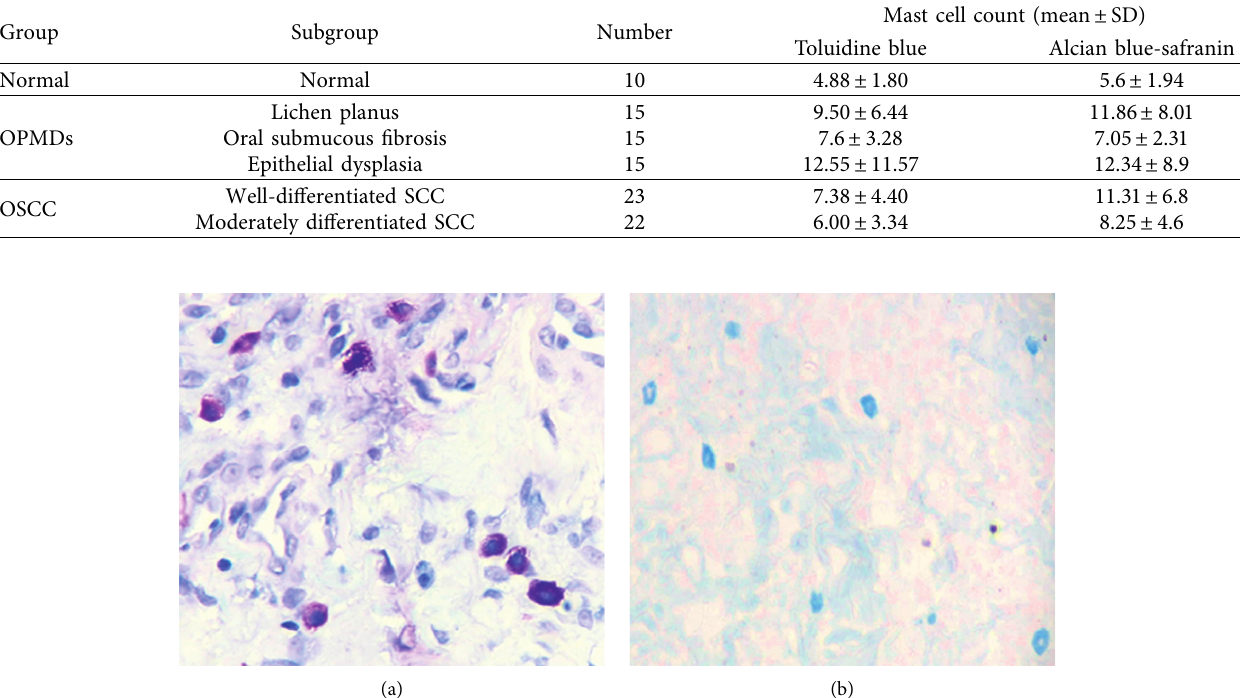
Table 1: Mast cell count using toluidine blue and Alcian blue stain among subgroups.